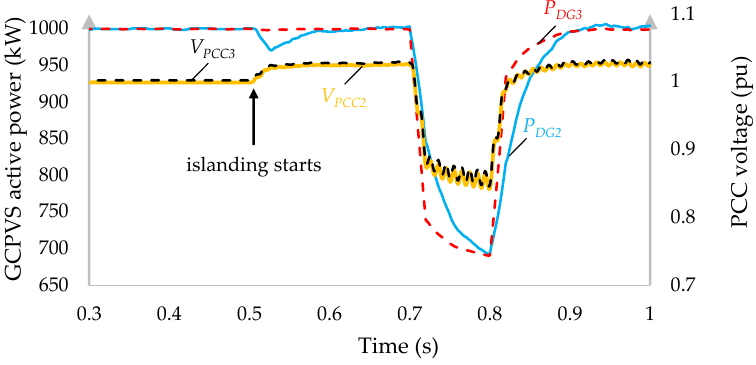
Figure 9. Results of multi DGs islanding case of the same bus connection.